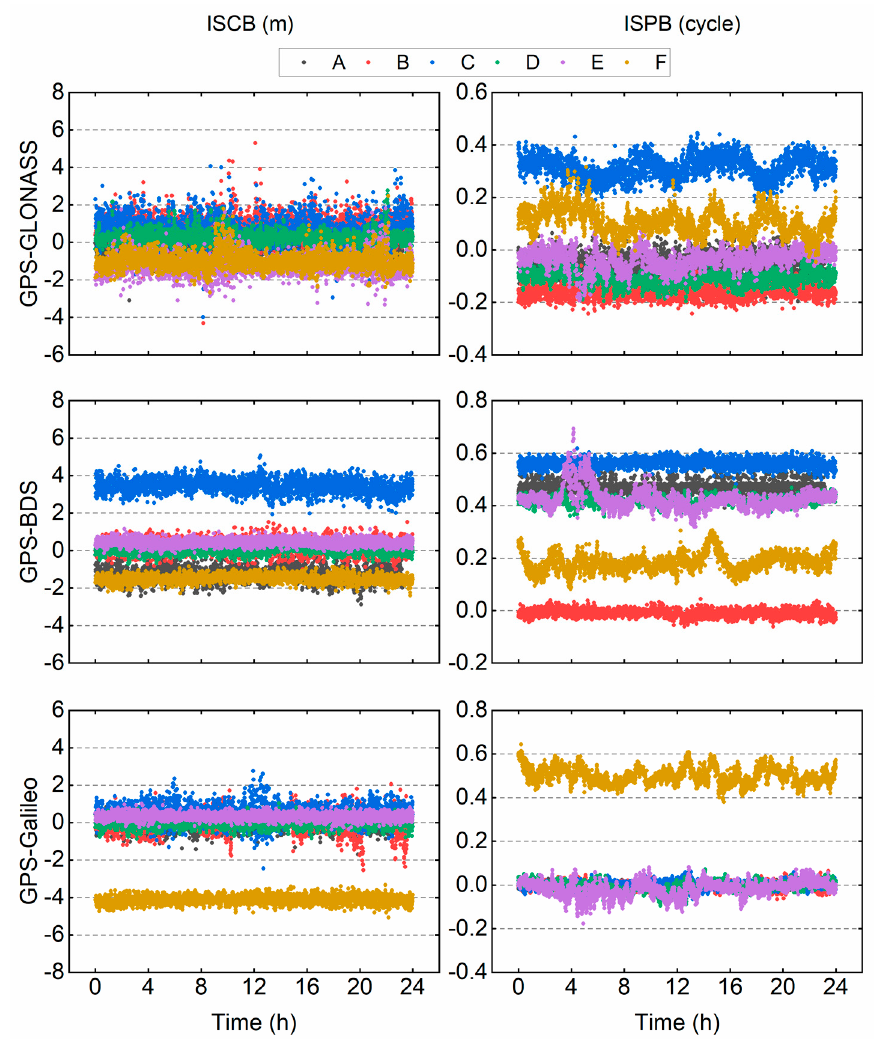
Figure 3. Estimated epoch-by-epoch inter-system bias (ISB): left—inter-system code bias ( ISCB ), right—inter-system phase bias ( ISPB ). The up, middle, and bottom panels contain the ISB values between GPS and GLObal NAvigation Satellite System (GLONASS), between GPS and BeiDou Navigation Satellite System (BDS), and between GPS and Galileo, respectively. In the figure, the dots with different colors denote different baselines.